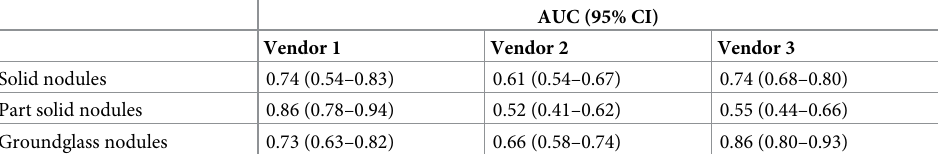
Table 4. Summary of areas under the curve with 95% confidence interval (AUC 95% CI) for detection of solid, part-solid and ground-glass nodules with the three AI algorithms assessed in our